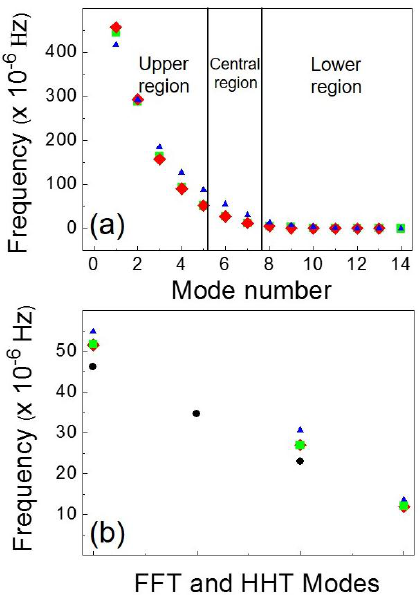
Figure 6. ( a ) HHT-EMD frequencies for the reactive power of L 1 , L 2 and L 3 subdivided into the three frequency regions (upper, central and lower) of the HHT spectrum. Green squares: HHT frequencies for Q 1 . Red diamonds: HHT-EMD frequencies for Q 2 . Blue up triangles: HHT frequencies for Q 3 . ( b ) Main FFT frequencies compared to the HHT-EMD frequencies of the central region for the reactive power of L 1 , L 2 and L 3 . Black circles: FFT harmonics H 1 , H 2 , H 3 and H 4 . The meaning of the other symbols is the same as in panel ( a ).